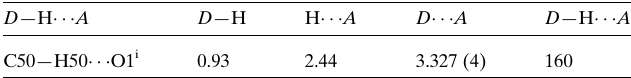
Table 1 Hydrogen-bond geometry (A˚ , (cid:2) ).